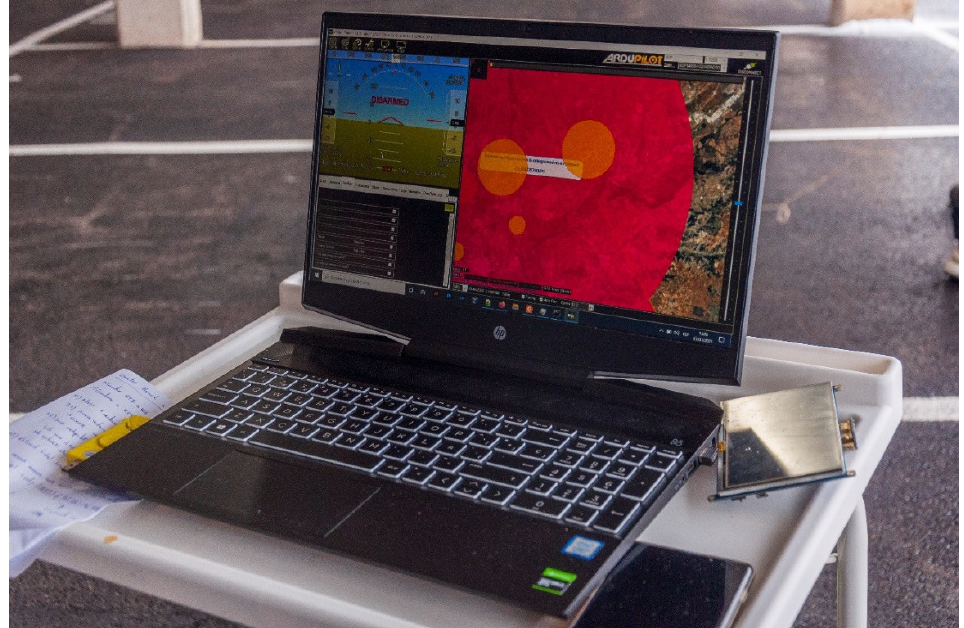
Figure 6. Laptop used as CGS during testing .